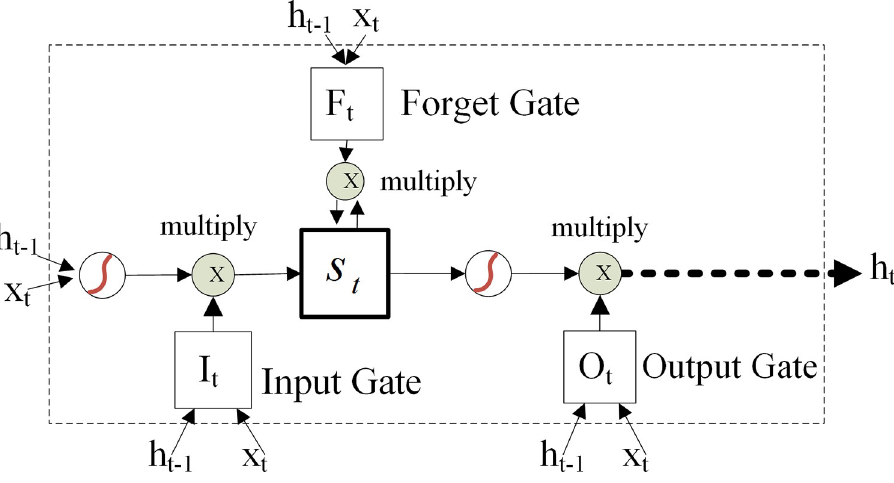
Fig 3. An illustrative structure of a LSTM